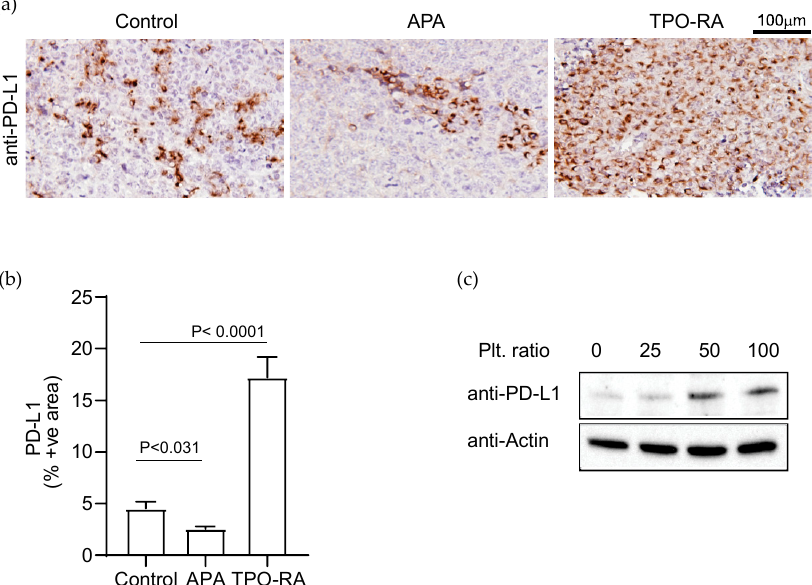
Figure 1. Platelets increase the expression of immune checkpoint protein, PD-L1, in the orthotopic murine model of ovarian cancer. ( a ) Representative images of PD-L1 immunostaining in tumor specimens induced by A2780 human ovarian cancer cells in Nu / Nu mice. APA: antiplatelet antibody, ASA: Aspirin, and Tica: Ticagrelor. ( b ) The relative expression of PD-L1 in tumor nodules resected from APA-, ASA-, and Tica-treated tumor-bearing mice was quantified by measuring positively stained surface area using ImageJ (National Institutes of Health, http://rsb.info.nih.gov/ij/index.html, accessed on 20 October 2020). The results are shown as the percentage of the immunostained area [PD-L1(+) area/total surface area × 100]. The statistical significance was calculated using a two-tailed t -test ( n = 9 (3 tumor nodules per mouse × 3 mice)).